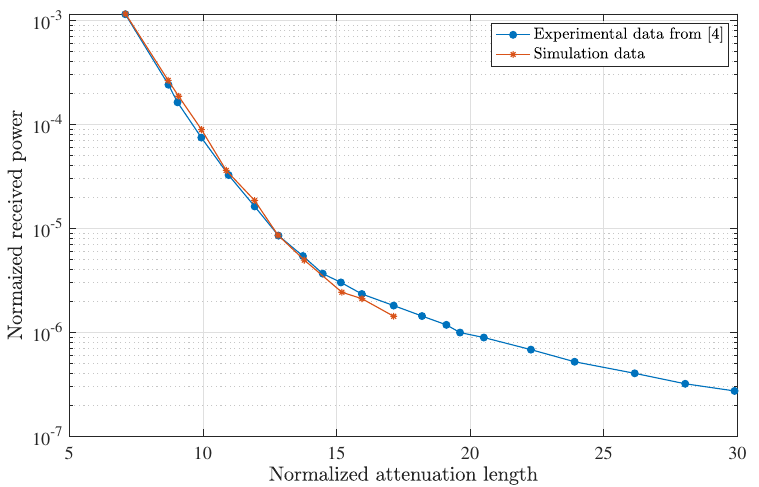
Figure 4. Comparison of simulation results for the normalized received power with Cox and Muth’s experimental data for a 3.6m water tank, with different attenuation coefficients made by adding different quantities of scattering agent